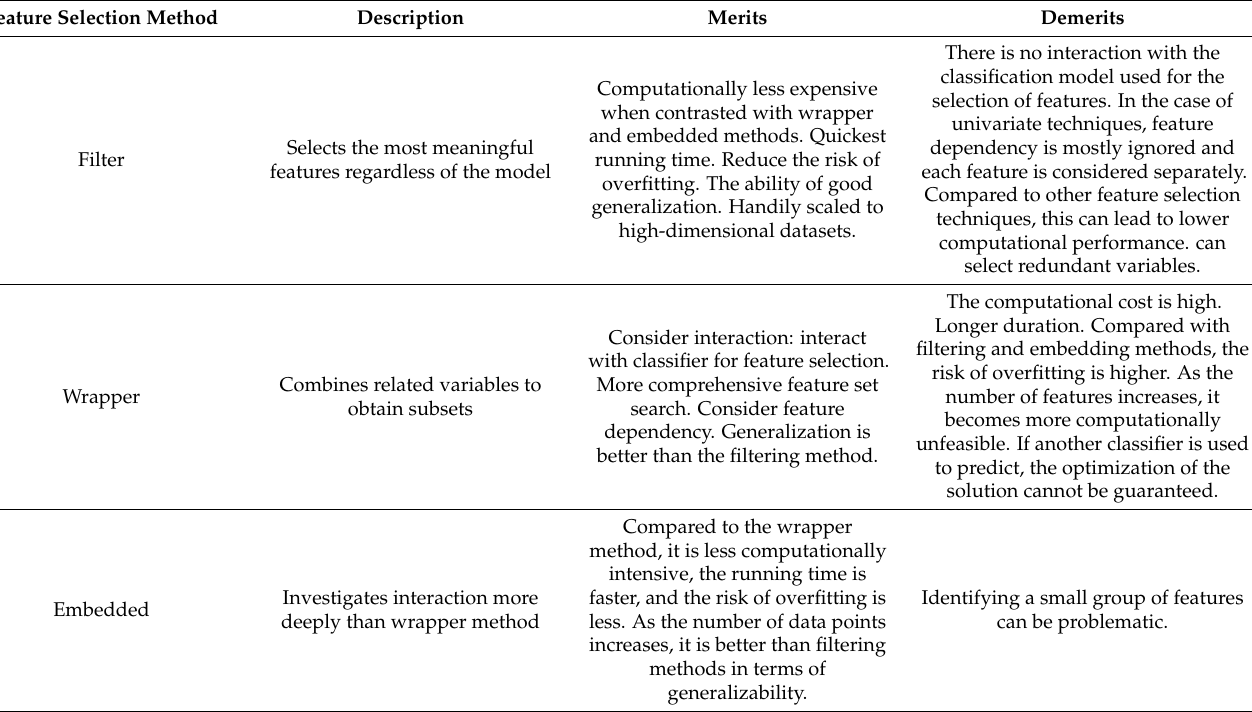
Table 5. Merits and demerits of filter, wrapper, and embedded feature selection methods